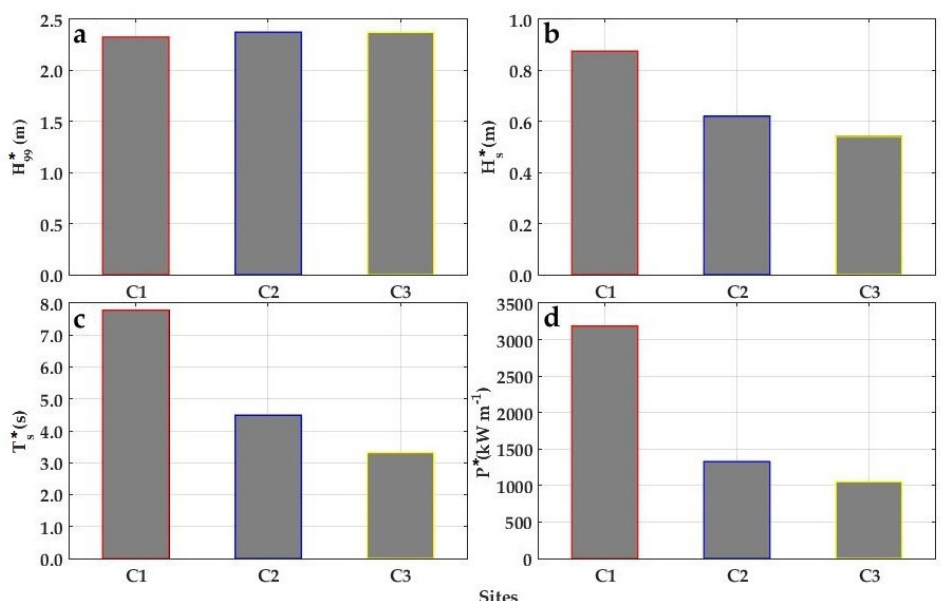
Figure 5. Multi-year means of H 99 , H s , T s and P at C1, C2 and C3 for the whole 40-year period (1980–2019): ( a ) H 99 *; ( b ) H s *; ( c ) T s * ; ( d ) P *.